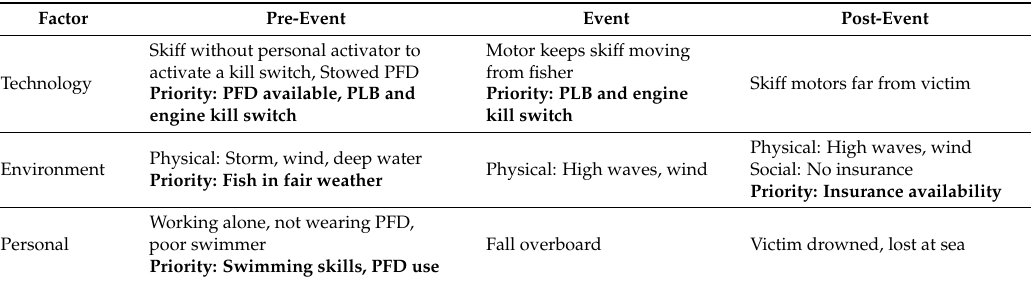
Table 6. An exemplar scenario of the application of the Haddon Matrix used to identify risk factors regarding a fatal incident and for setting intervention